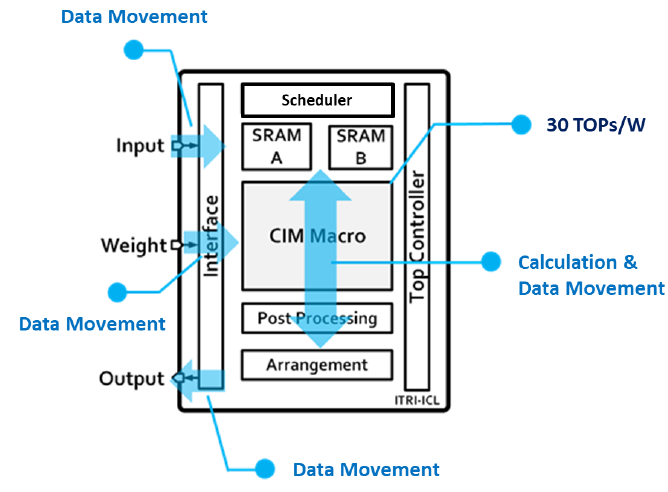
Figure 4. SRAM-based CIM chip architecture design.